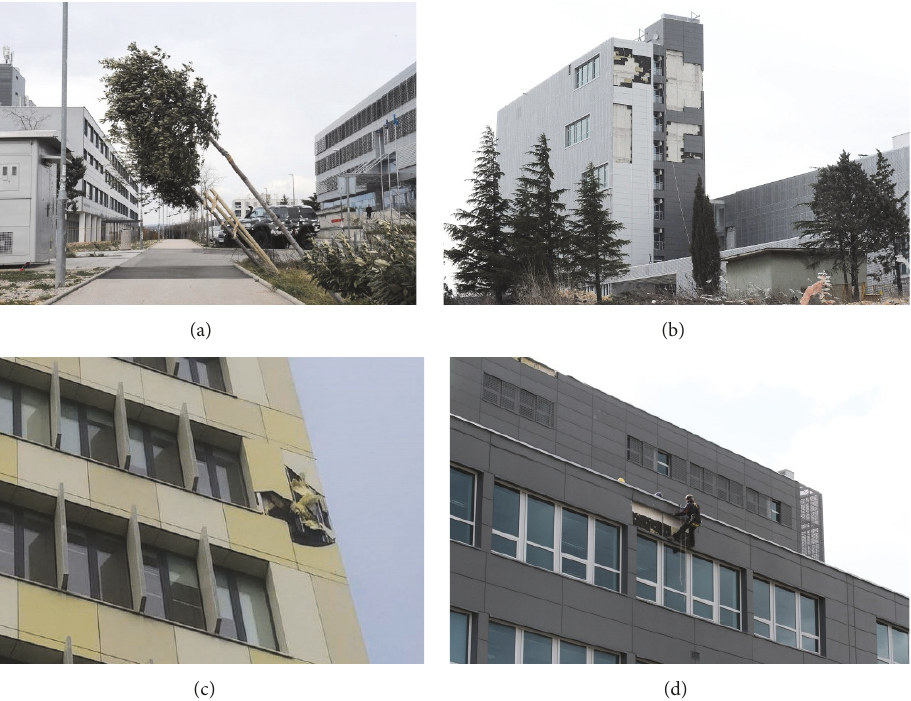
Figure 3: Damage on the Campus property and environment caused by the wind Bura: (a) and (b) damage in March 2015; (c) and (d) damage in January 2017.